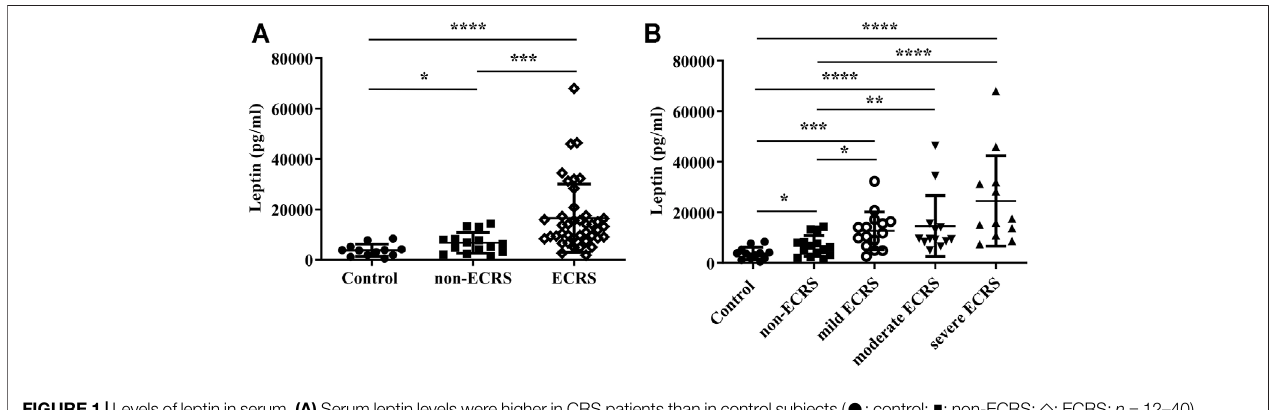
FIGURE 1 | Levels ofleptin in serum. (A) Serum leptin levels were higher in CRS patients than in control subjects ( C : control; ■ : non-ECRS; ◇ : ECRS; n (cid:1) 12 – 40). (B) Serum leptin levels were higher in patientsECRS subjects than in those withnon-ECRS and control subjects( C : control; ■ : non-ECRS; ○ : mild ECRS; ▼ : moderate ECRS; ▲ : severe ECRS; n (cid:1) 12 – 15). * p < 0.05; *** p < 0.001; **** p <